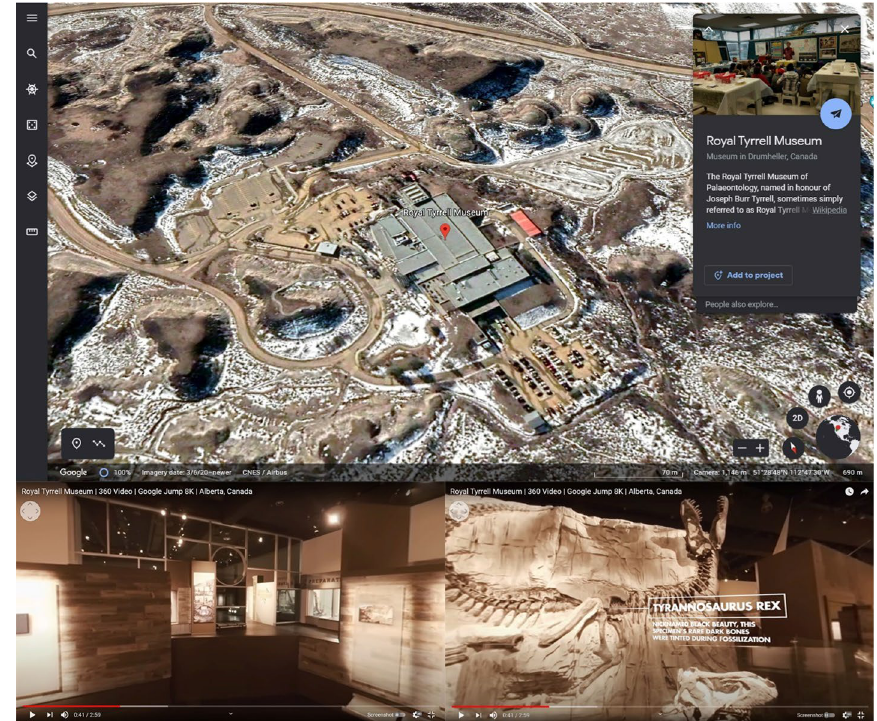
Fig. 1 Tour recording of a virtual field trip to the royal Tyrell Museum, Alberta,